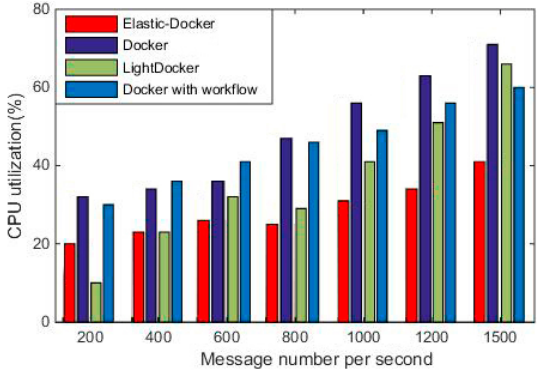
Figure 11. Comparison of CPU consumption.